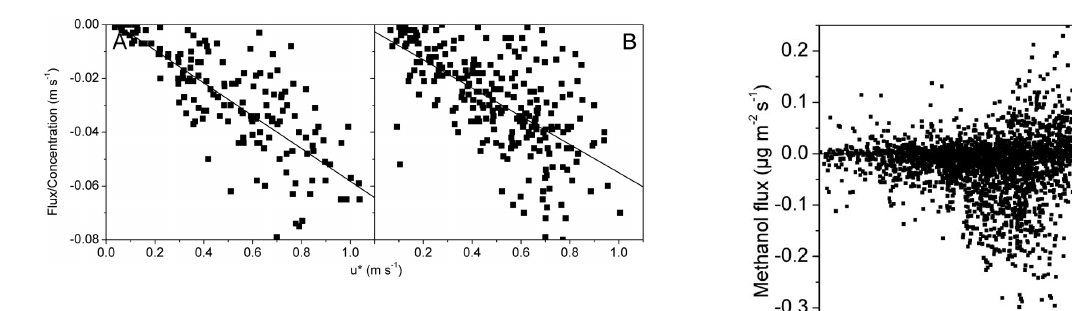
Fig. 6. Relationship between the ratio methanol flux/ambient methanol concentration and the friction velocity ( u ∗ ) in night (A) and day (B) conditions for July-August-September 2009, re- specting these conditions: flux < 0µgm − 2 s − 1 , < 0.15kPa and > − 20Wm − 2 . Fig. 7. Methanol flux in relation with the air temperature for July-